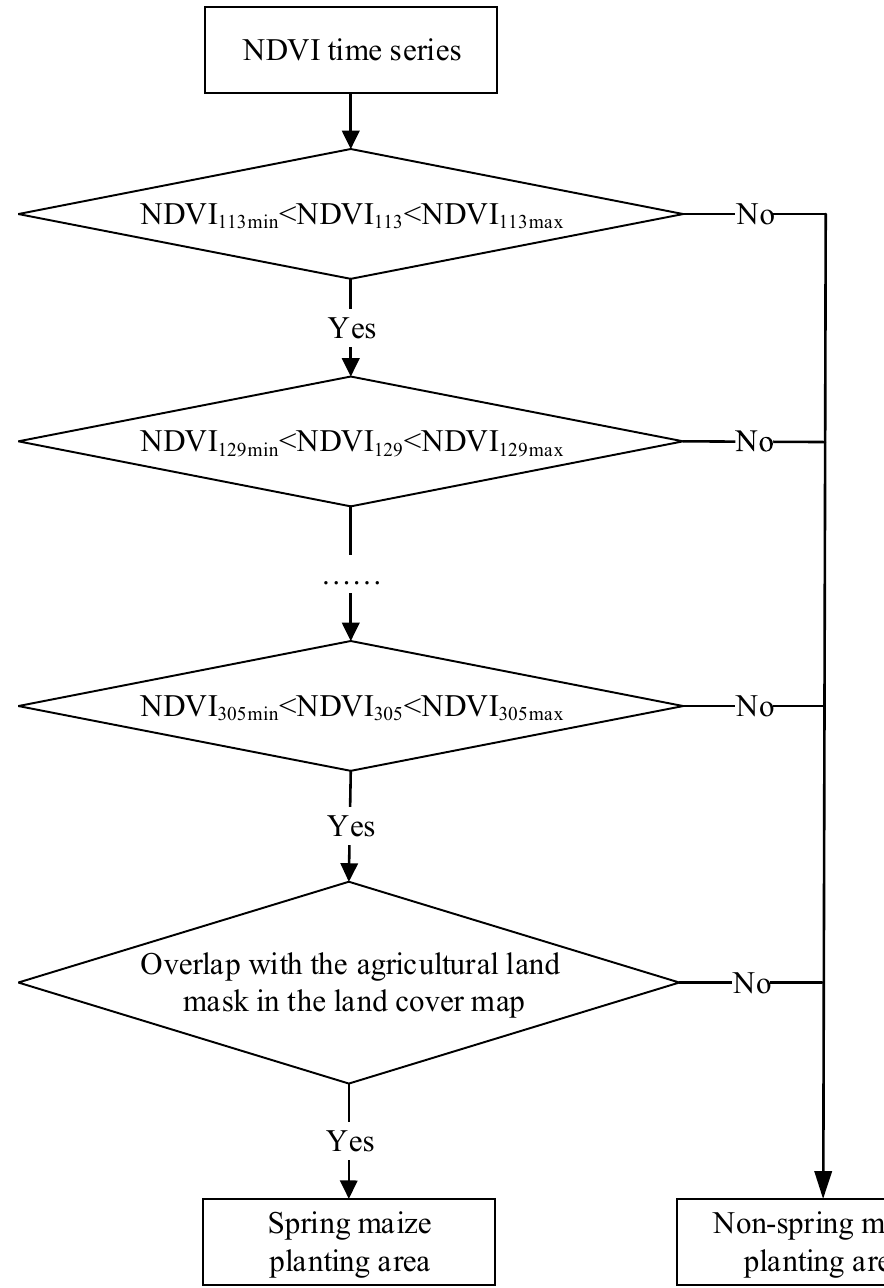
Figure 9. Schematic map of decision tree classification extraction for spring maize planting area. The map of the multi-year average spring maize planting area in Jilin Province was obtained by accumulating the raster files of planting areas in previous years, and a raster was considered to belong to the multi-year average spring maize planting area when the number of years in which a raster appeared exceeded 7 years. This planting area map was used to clip the ET a raster data of Jilin Province calculated by PySEBS software to obtain the ET a of spring